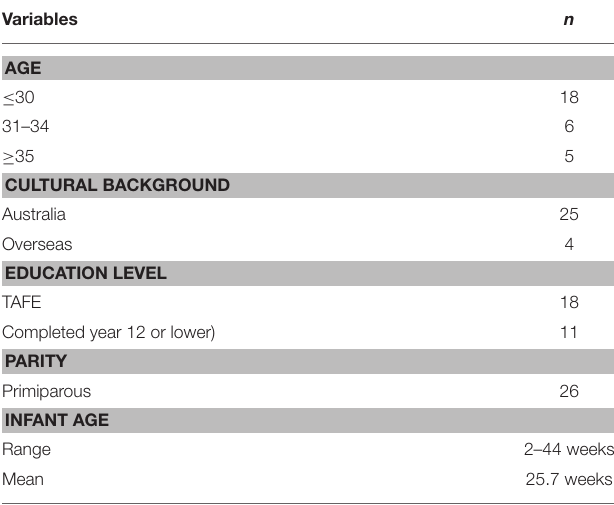
TABLE 3 | Study 2: participant